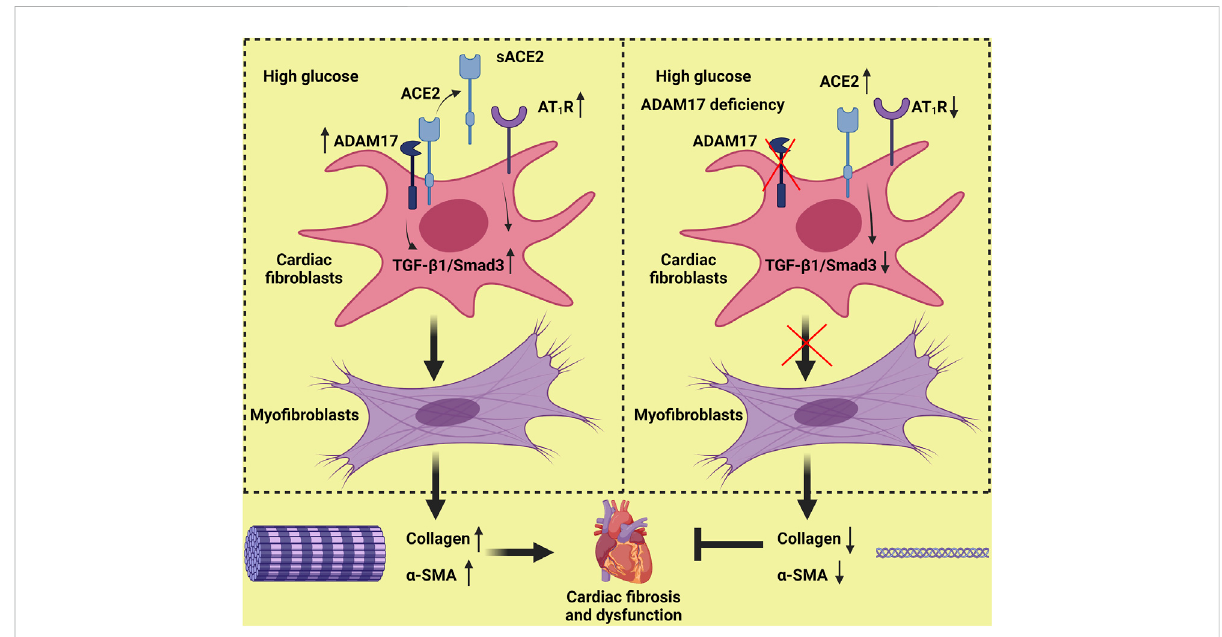
FIGURE 7 Proposed mechanisms underlying the roles of ADAM17 in cardiac fi brosis. High glucose increases ADAM17 activity, ACE2 shedding and AT1R expression, which activates TGF- β 1/Smad3 signaling in cardiac fi broblasts, leading to an enhanced myo fi broblast transformation and collagen deposition in the myocardium. ADAM17 de fi ciency attenuates ACE2 shedding and AT1R expression, which inactivates TGF- β 1/Smad3 signaling in cardiac fi broblasts, leading to areducedmyo fi broblast transformation and collagen depositioninthemyocardium, thusameliorating diabetes- induced left ventricular dysfunction and cardiac fi